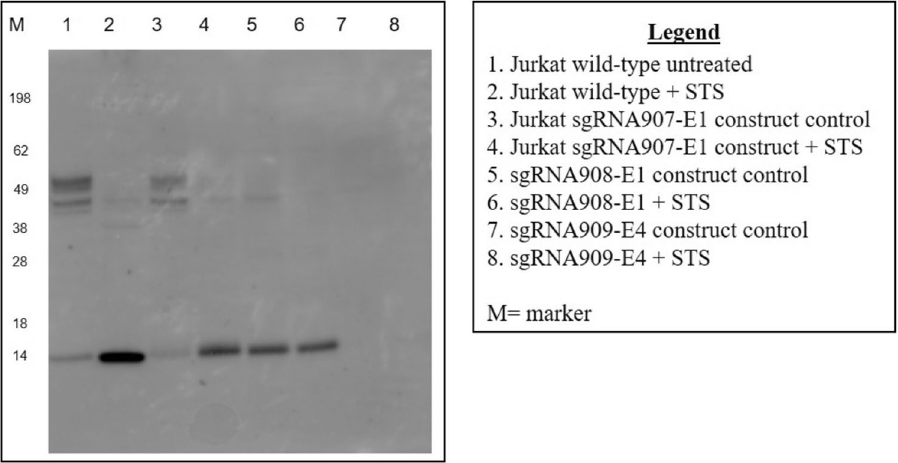
Figure 4. Western blot analysis of Panx1 protein K/O in Jurkat cells. Jurkat cells stably expressing Cas9 were transduced with three different sgRNA’s each targeting a different exon sequence of the Panx1 gene: sgRNA907 (exon 1), sgRNA908 (exon 2), and sgRNA909 (exon 4). Analysis was performed with cells that were successfully transduced and that were expanded through the usage of selection media and single cell isolation/cloning.